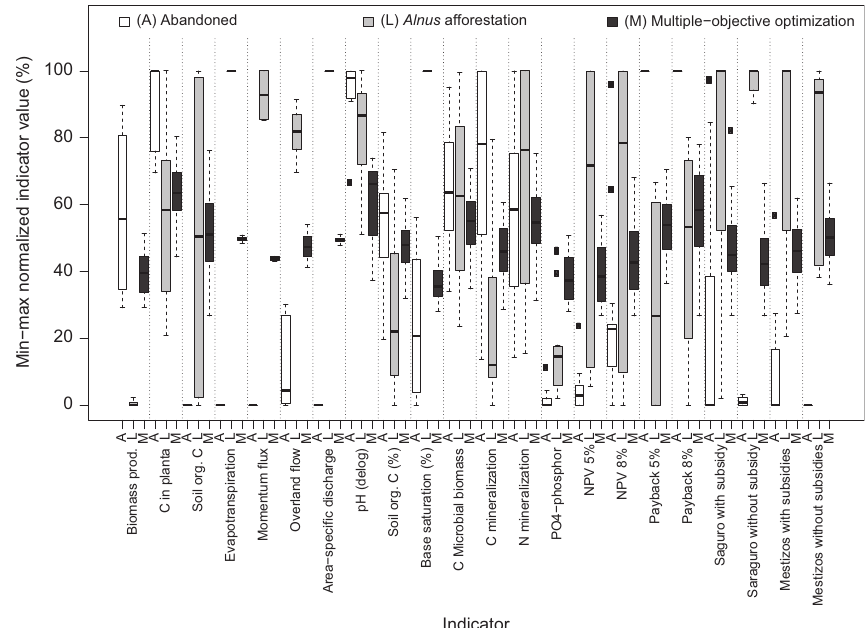
Figure 7 | Normalized landscape scale indicators. Whiskers: minima and maxima, boxes formed by quartiles comprising the median. Multiple-objective optimization is compared with single land-use options for an uncertainty level of f u ¼ 2.